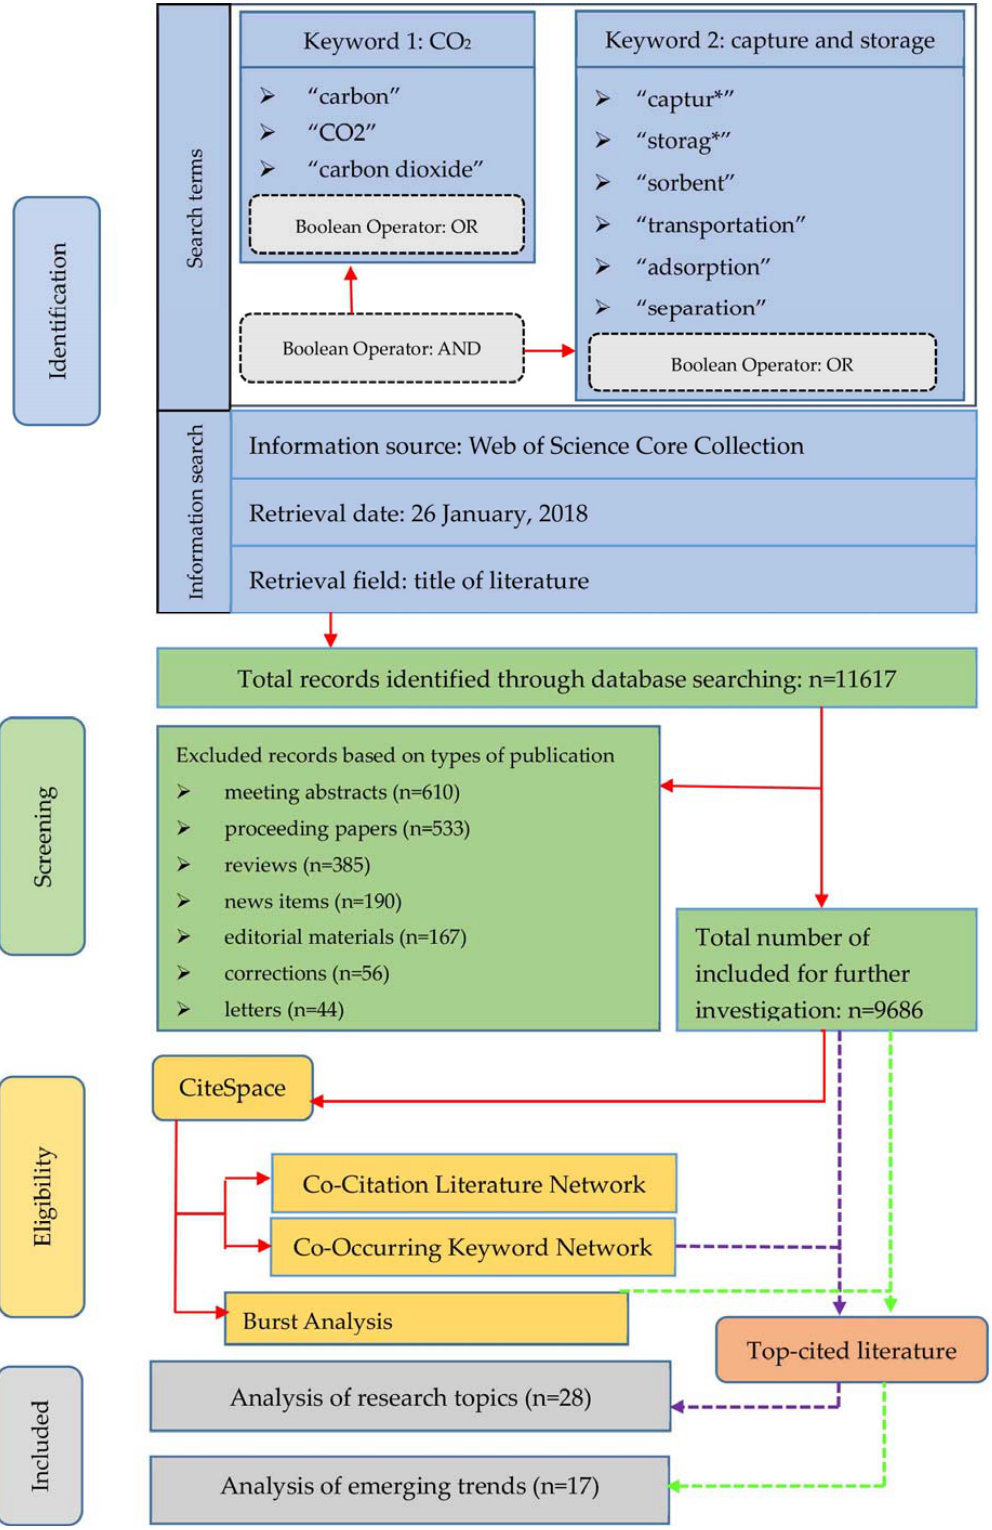
Figure 1. Process of literature retrieval and selection.